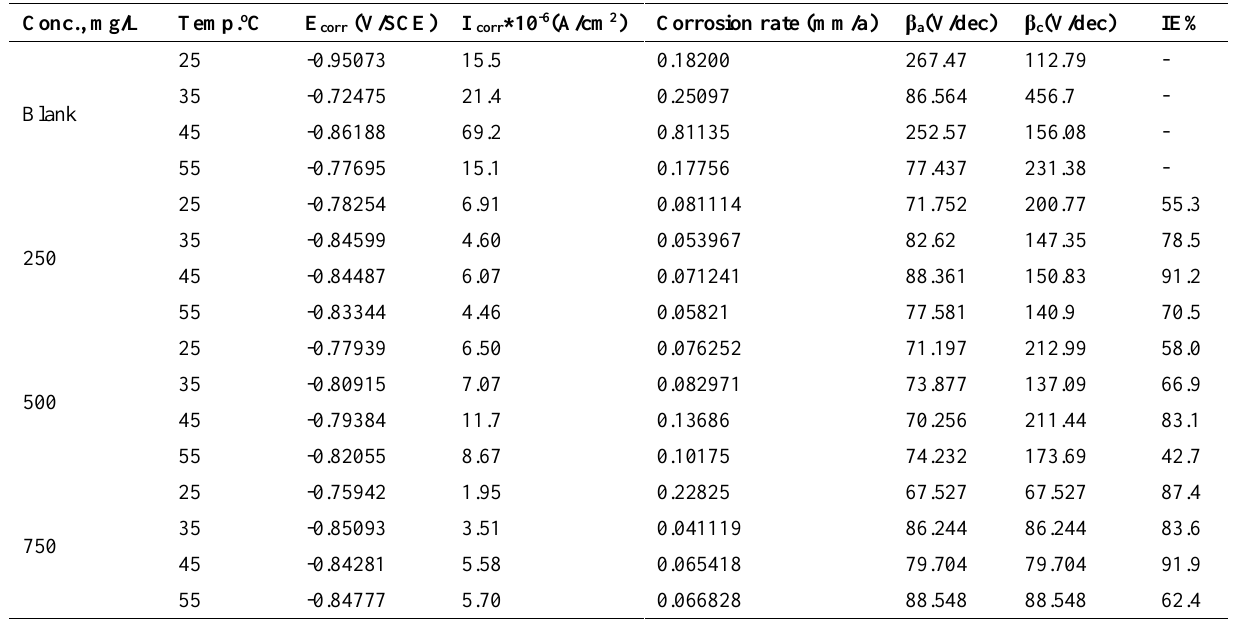
Electrochemical study of